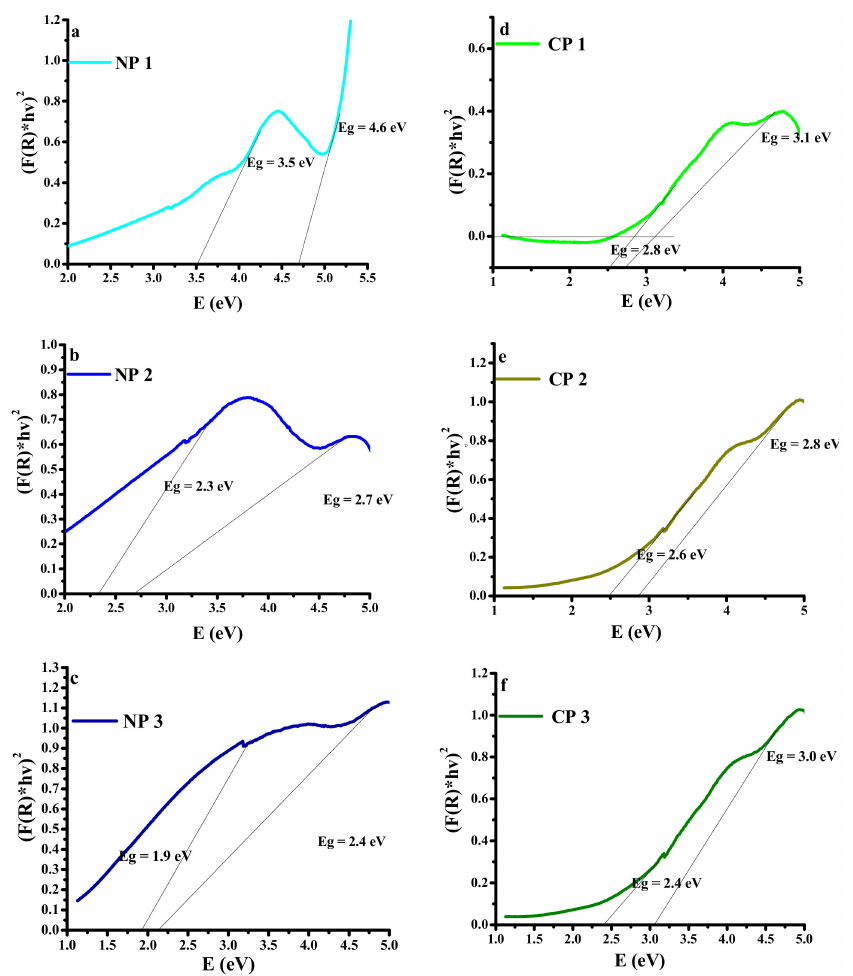
Figure 5. Plot of (F(R)h υ ) 2 vs. photon energy for the samples; ( a ) NP1; PVA/NiO (0.1%), ( b ) NP2; PVA/NiO (0.2%), ( c ) NP3; PVA/NiO (0.3%), ( d ) CP1; PVA/CuO (0.1%), ( e ) CP2; PVA/CuO (0.2%), ( f ) CP3; PVA/CuO (0.3%). Table 2. Calculation of bandgap of all the prepared composites using Kubelka–Munk Equation [29]. Sr.